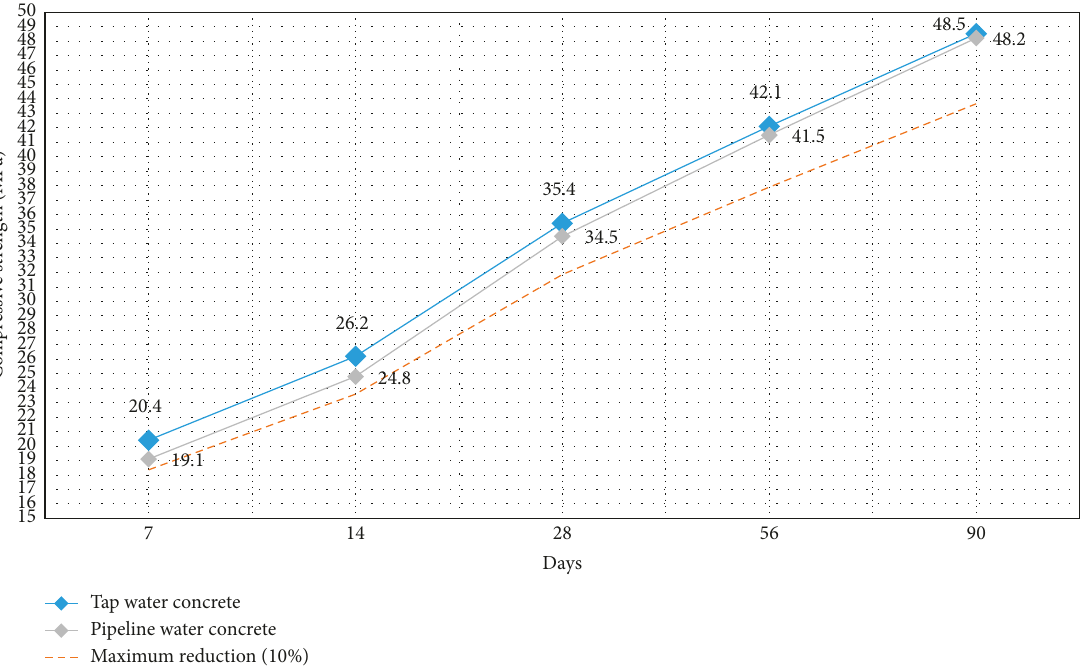
Figure 12: Comparative chart of compressive strength results for granite concrete samples made by using tap water and pipeline